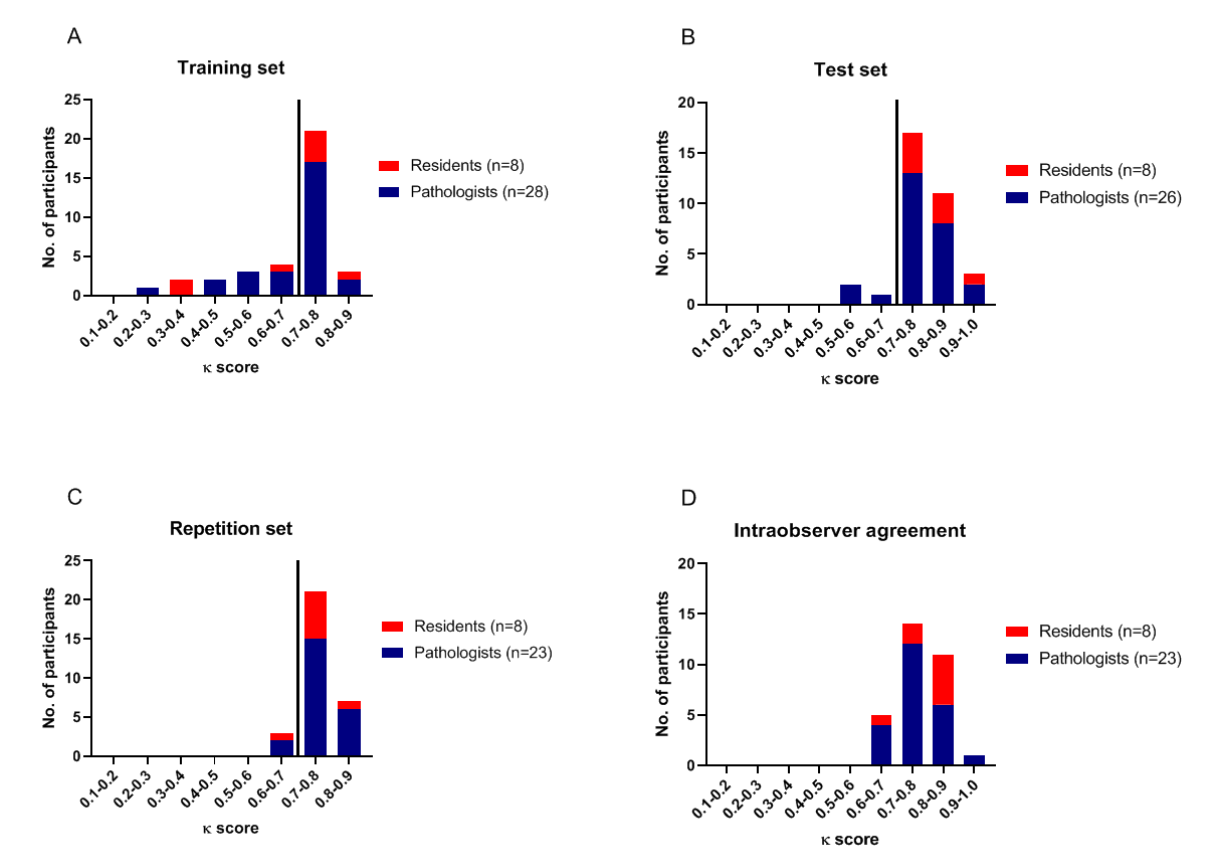
Figure 2. Distribution of κ scores for each set of the e-Learning: (A) training set, (B) test set, (C) repetition set, and (D) intraobserver agreement.